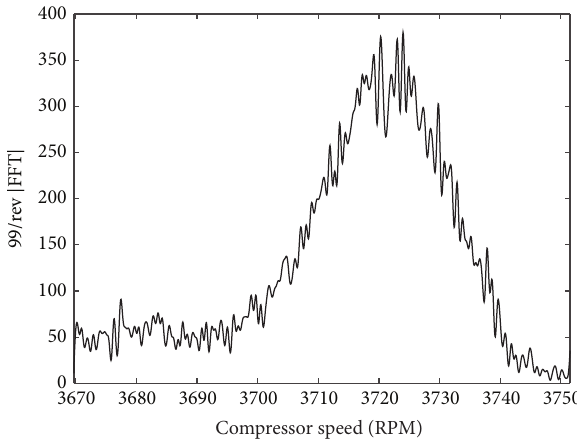
Figure 11:Themagnitude of thespectral component associated with the 99/rev frequency at nominal